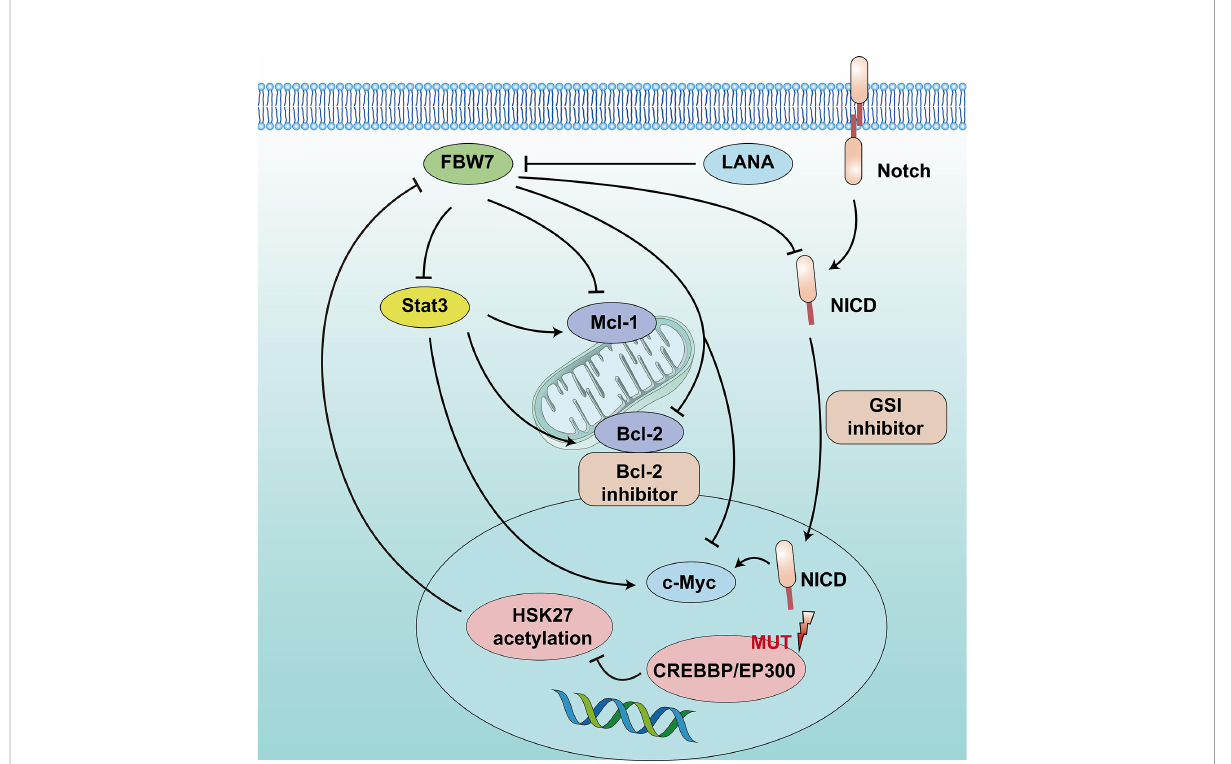
FIGURE 2 Schematic diagram of FBW7-mediated oncogene and signaling pathway in B lymphoproliferative malignancies. 1) CREBBP/EP300 mutations inhibit H3K27 acetylation, downregulate FBW7 expression, and activate the Notch pathway to promote cell proliferation. 2) Dysregulation of FBW7 could upregulate Stat3 expression and increase downstream antiapoptotic target genes, including c-Myc, Mcl-1, and Bcl-2, to induce cell proliferation and inhibit